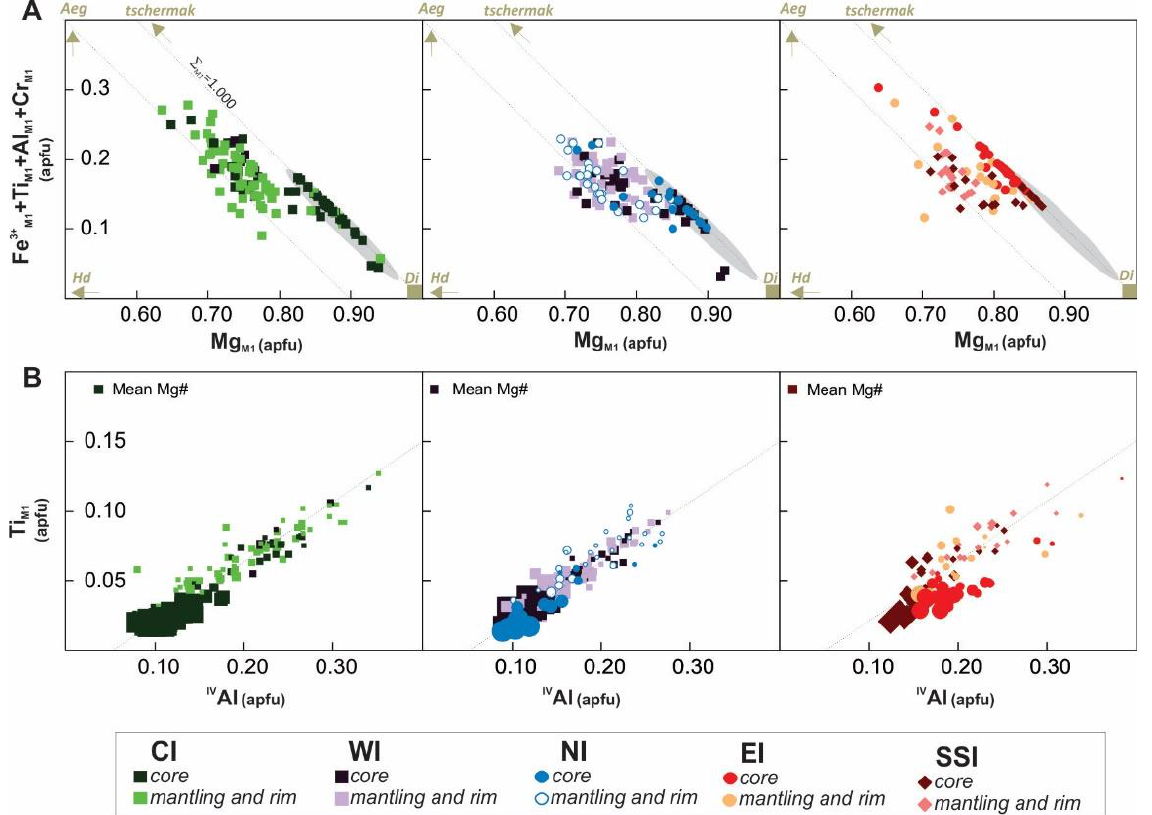
Figure 5. Clinopyroxene compositions of the Ponte Nova mafic – ultramafic alkaline massif. ( A ) Mg M1 vs Fe 3+ +Ti M1 + Al M1 +Cr M1 , shows the main solid solution endmembers of these crystals and favoring substitutions of diopside(Di) with hedenbergite(Hd) and with the main Ca-tschermak endmembers (Ca VI Al IV AlSiO 6 , CaTiAl 2 O 6 and CaFe 3+ AlSiO 6 ). In ( B ), the importance of CaTiTs component is em- phasized in the positive correlation of IV Al in the tetrahedral site with Ti 4+ in the M1 site. A third component qualitatively indicated in this graph is the Mg #cpx , which can be evaluated based on the symbol size (higher Mg#, bigger symbols).